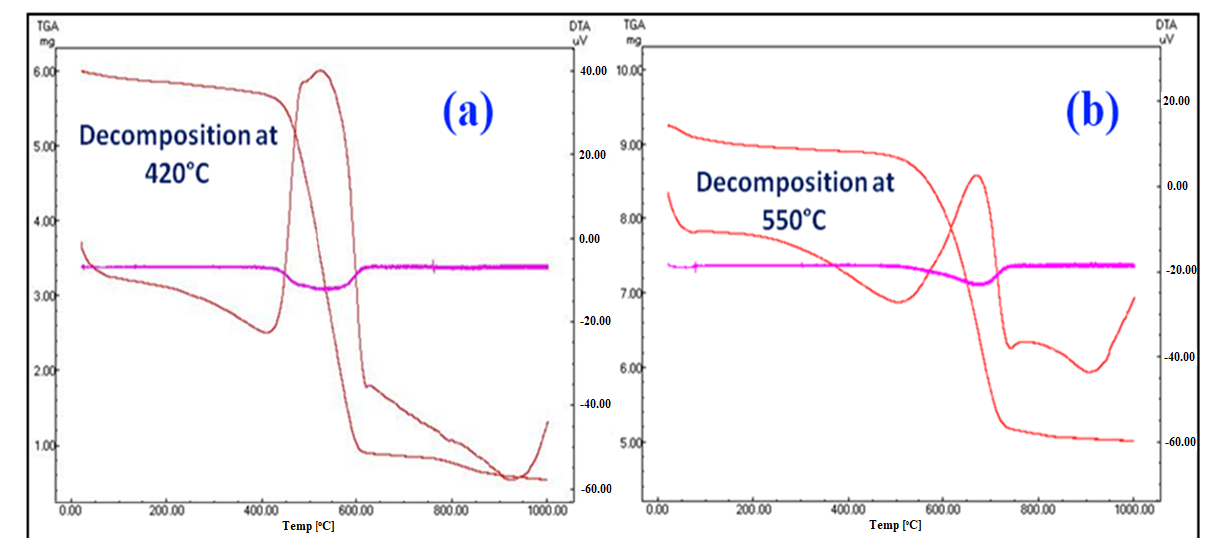
Figure 5. TGA/DTA curves of ( a ) original FA and ( b ) FA-TiO 2 recorded from room temperature to 1000 °C.